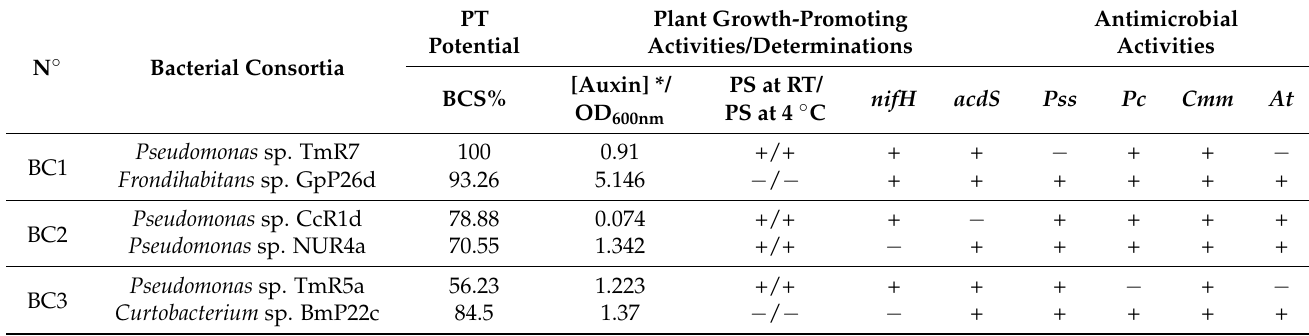
Table 6. Characteristics of the selected bacterial consortia.